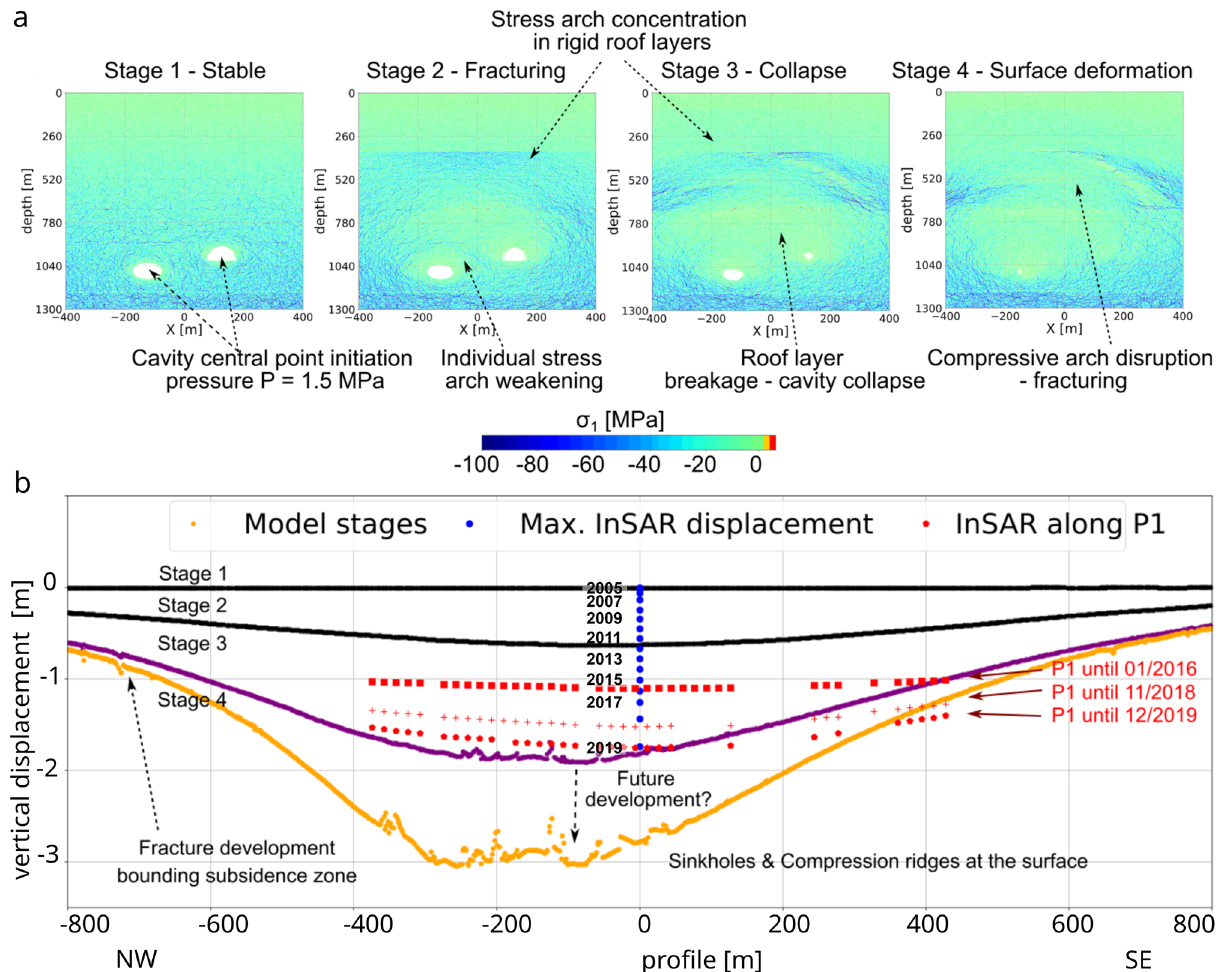
Figure 5. Simulated DEM subsidence models for depressurized cavity scenario (S2, P = 1.5 MPa). ( a ) Maximum compressive stress representation of the four stages of cavity collapse; blue colour shows higher values of compressive stress. ( b ) Induced surface deformations for the four stages (black-purple-yellow colour scale) compared to InSAR surface subsidence results along the profile P1 (Fig. 3a). The figures were plotted using Matplotlib python library using data from simulations and InSAR time series data along profile